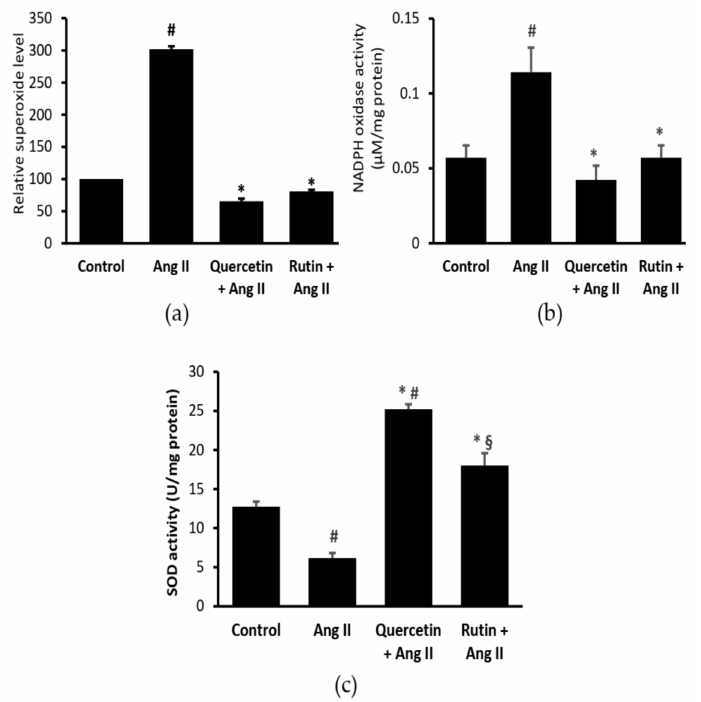
Figure 3. ( a ) Intracellular superoxide, ( b ) cellular NADPH oxidase, and ( c ) superoxide dismutase (SOD) activities in cardiomyocytes coexposed to Ang II and quercetin (331 µ M) or rutin (50 µ M) for 24 h. # p < 0.05 vs. control group, * p < 0.05 vs. Ang II group, § p < 0.05 vs. quercetin + Ang II. Data were analyzed by a one-way ANOVA followed by a Tukey post hoc test and are represented as the